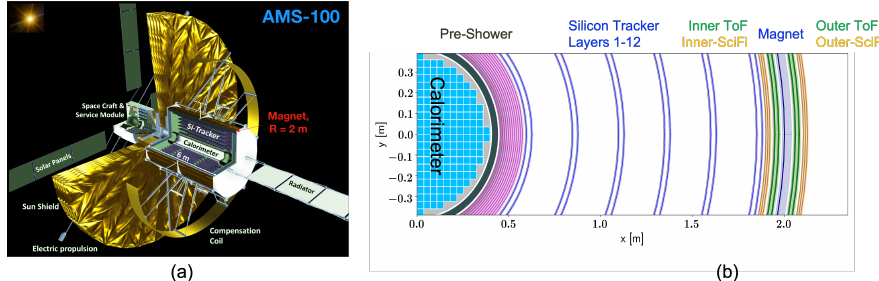
Figure 1. ( a ) A rendering of AMS-100 deployed in Space: The AMS-100 instrument has a cylindrical geometry with a radius of 2 m and a length of 6 m, surrounded by a compensation coil. In front of the sun-shield, it is equipped with solar panels, electrical propulsion system and a space craft service module. The rear radiator removes the heat from the instrument. ( b ) Cross-section of the AMS-100 detector with its cylindrical sub-detector